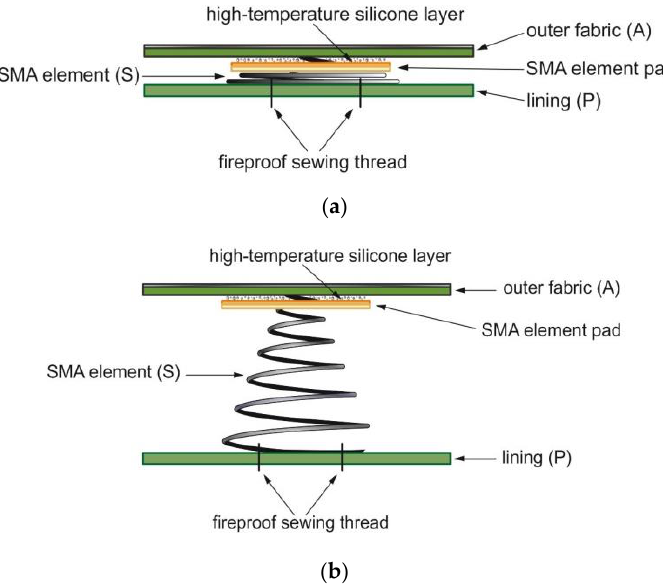
Figure 4. Design of smart textile material with SMA elements: ( a ) inactive state and ( b ) active state.